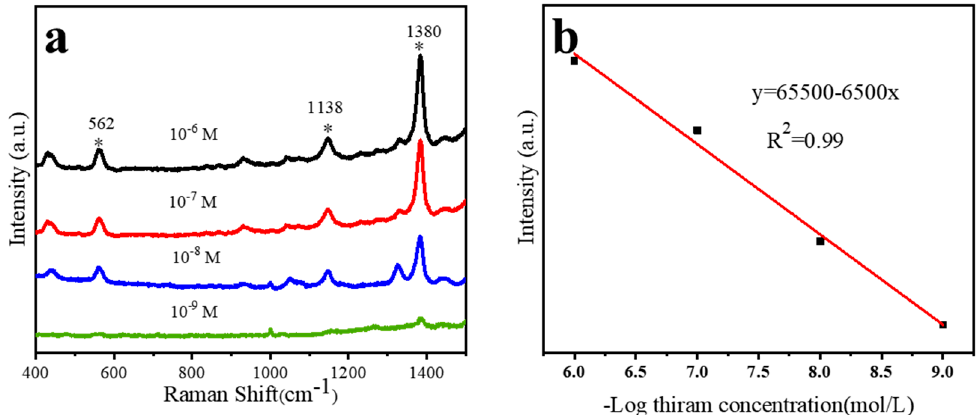
Figure 6. ( a ) SERS spectra of cluster in TiO 2 -Ag composite with different concentrations of thiram (10 − 6 –10 − 9 M); The star * highlights the position of the characteristic peak of thiram. ( b ) Take the negative logarithm of the concentration values of thiram with different concentrations as the X value and take the Raman peak at 1380 cm − 1 as the Y value as a linear function image.